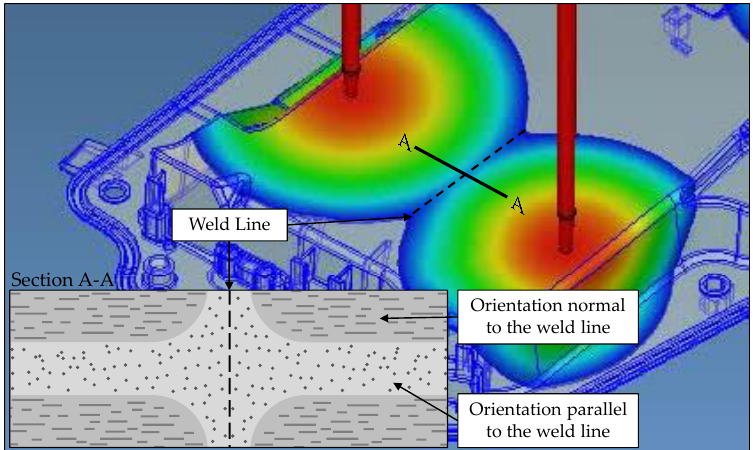
Figure 12. Schematic representation of the FO at a stagnating weld line. Moldex3D mold filling simulation was conducted by SimpaTec Inc. (Aachen, Germany).